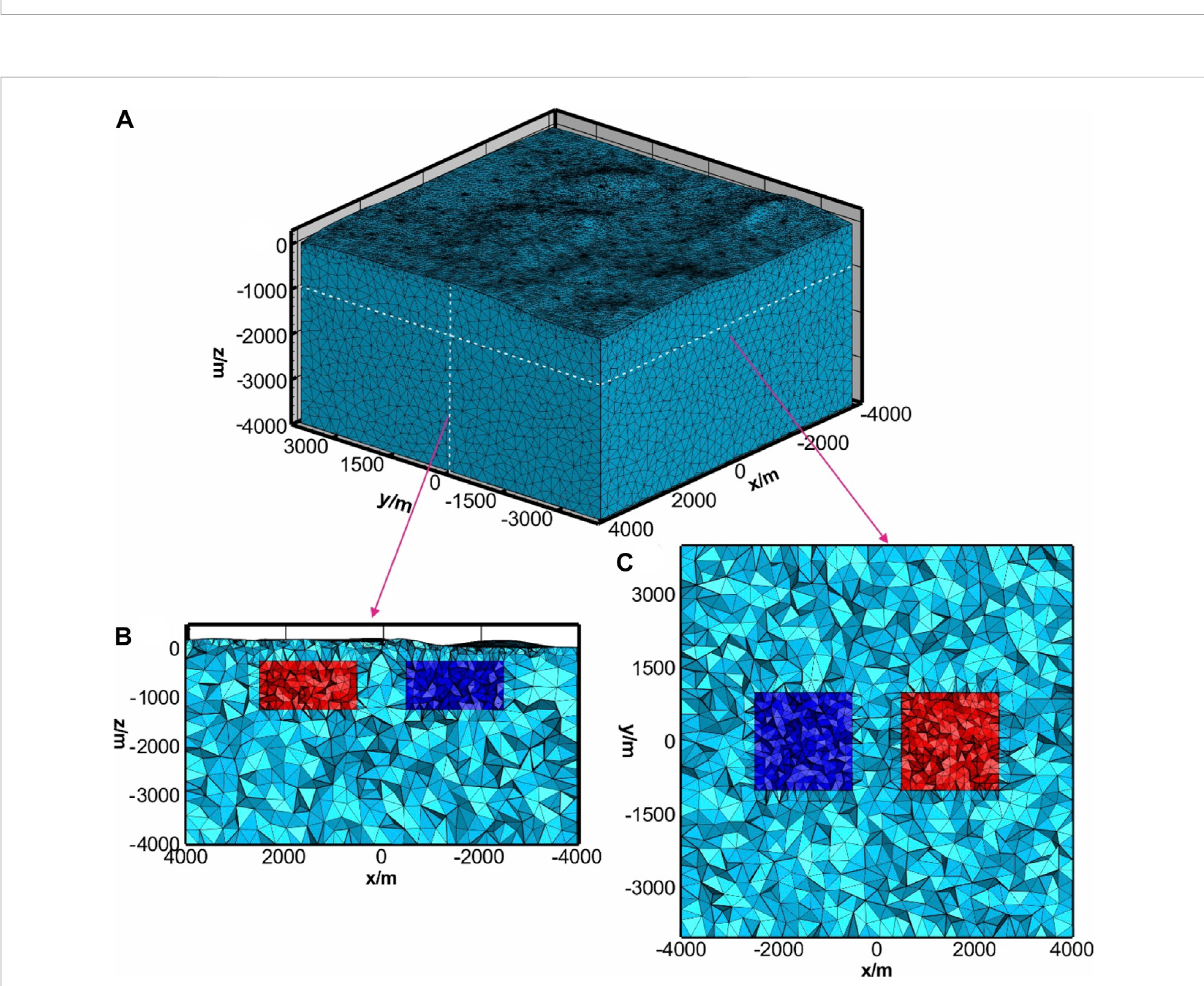
FIGURE 9 Model discretization for the forward modeling. (A) 3-D view of the models. (B) Side view of the model ( y =0 m). (C) Plane view of the model ( z = − 1100 m).